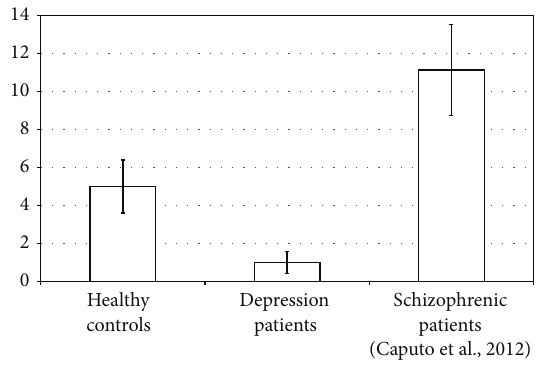
Figure 1: Cumulative duration of apparitions per minute of MGT [smin −1 ].